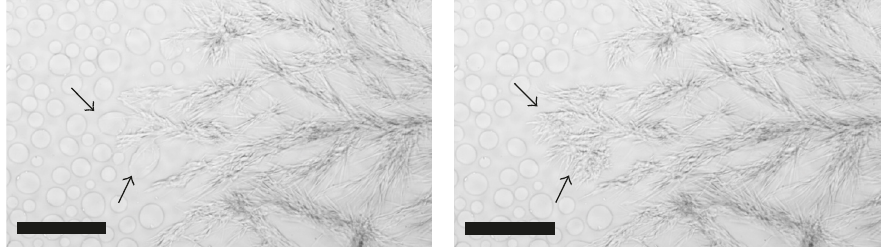
Figure 7: Time series of OM images for 3wt% 12-HSA/[ABIm][TFSI] gel at 75.5 ∘ C during the cooling process at a rate of 0.4 ∘ C/min. Scale bar is 100 𝜇